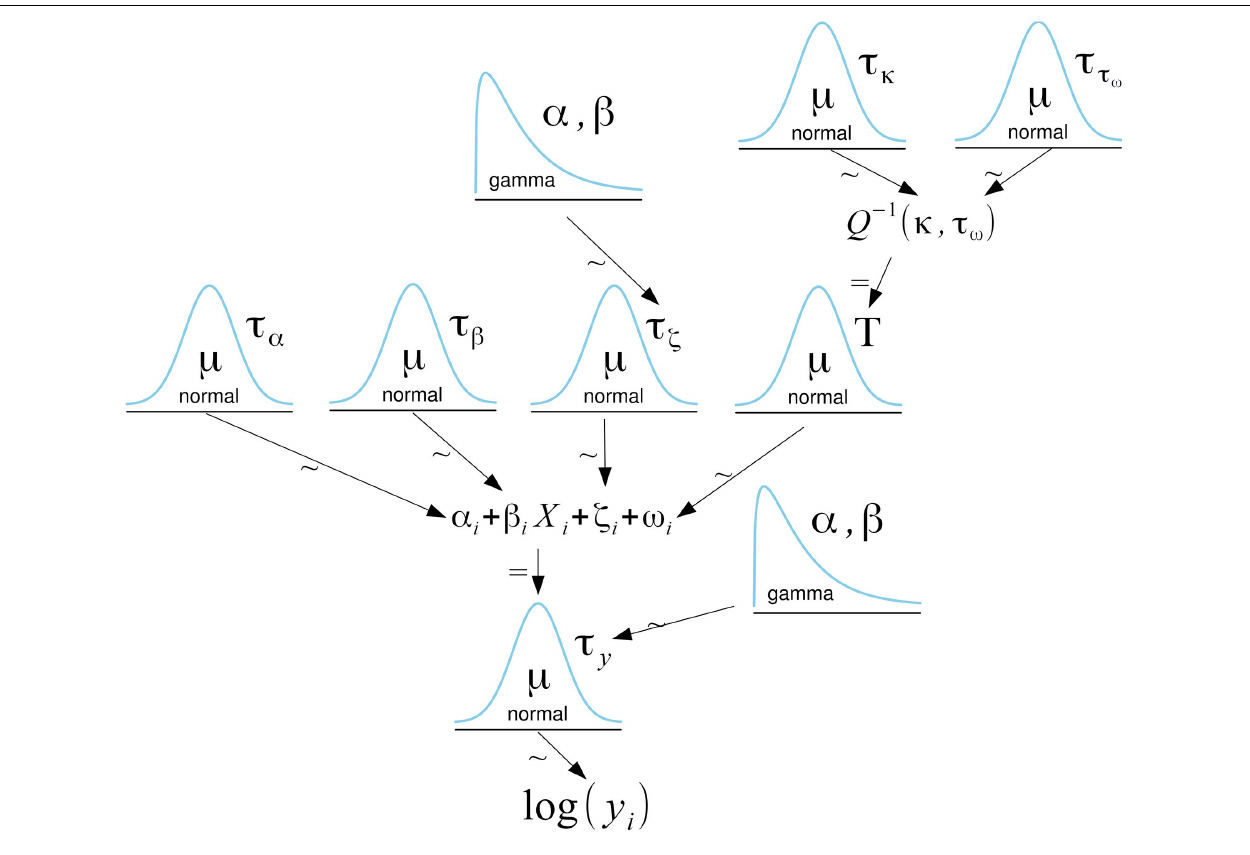
FIGURE 2 | Graphical representation of the model. The logarithm of the WPUE ( γ i ) follows a normal distribution. For the fixed effects parameters, vague Gaussian priors with a mean of 0 and a variance of 100 were used. ζ i is a Gaussian distributed random metier effect with a mean of 0 and a precision τ ζ . By default, INLA assigns a gamma prior with parameters 1 and 0.00005 to the precision. The random spatial effect ( ω i ) is approximated with a Matern covariance function (Q). The parameters κ and τ ω determine the range and the total variance of the spatial effect. The penalized complexity priors of these parameters follow a